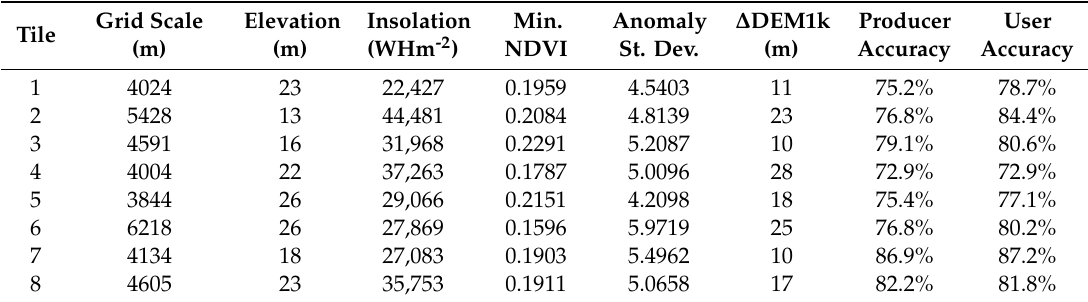
Table 3. Calibrated parameters for original normalized di ff erence vegetation index (NDVI) data (values do not include 25% overlaps).